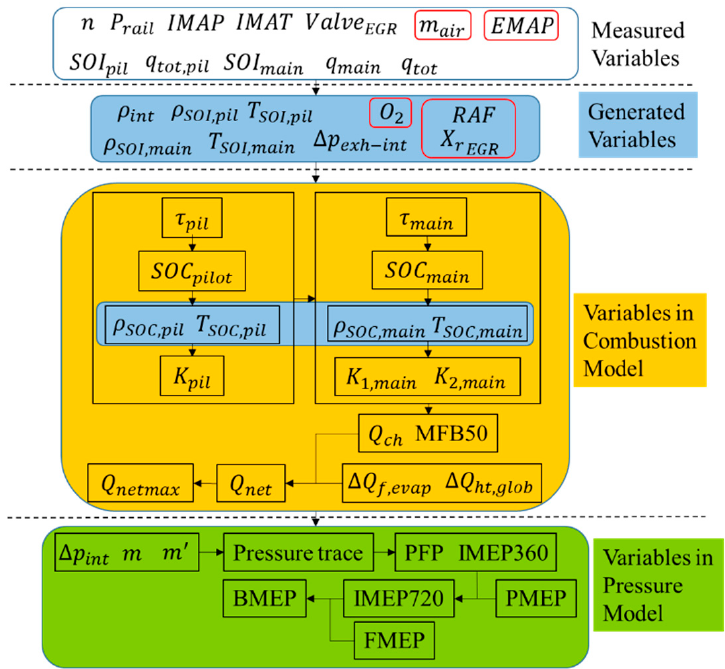
Figure A1. Temporal calculation sequence of the physics-based model variables.